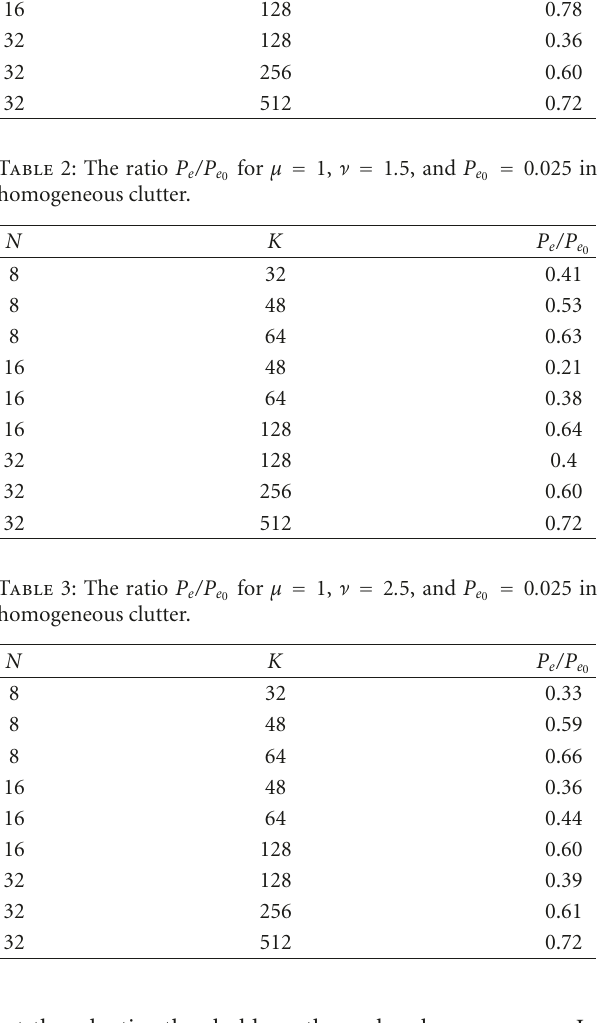
for μ = 1, ν = 1 . 5, and P e 0